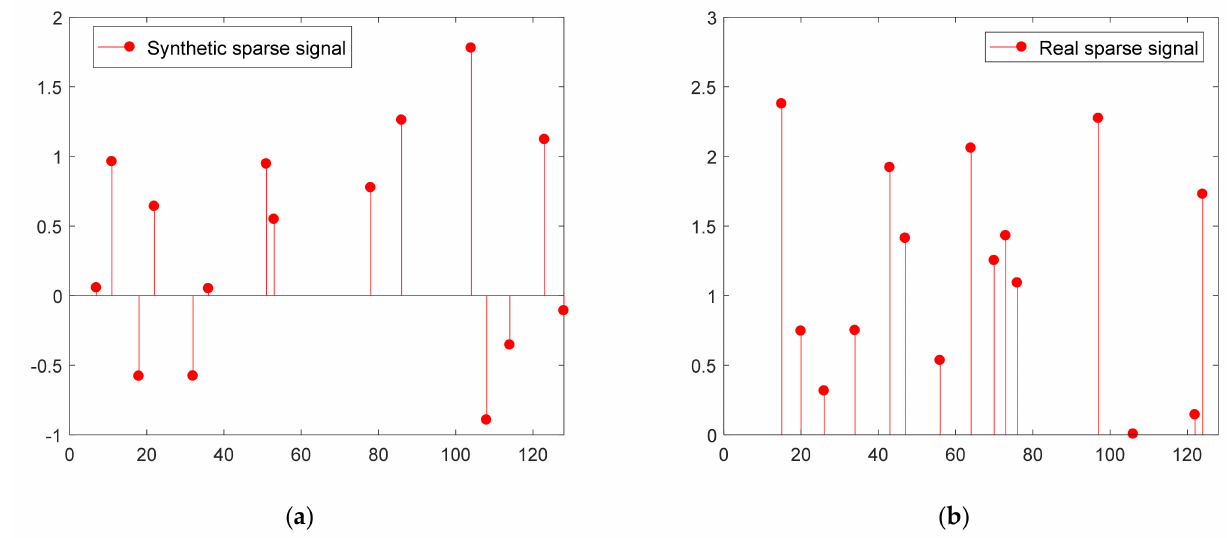
Figure 3. Examples of one-dimensional sparse data. ( a ) Synthetic signals; ( b ) Real